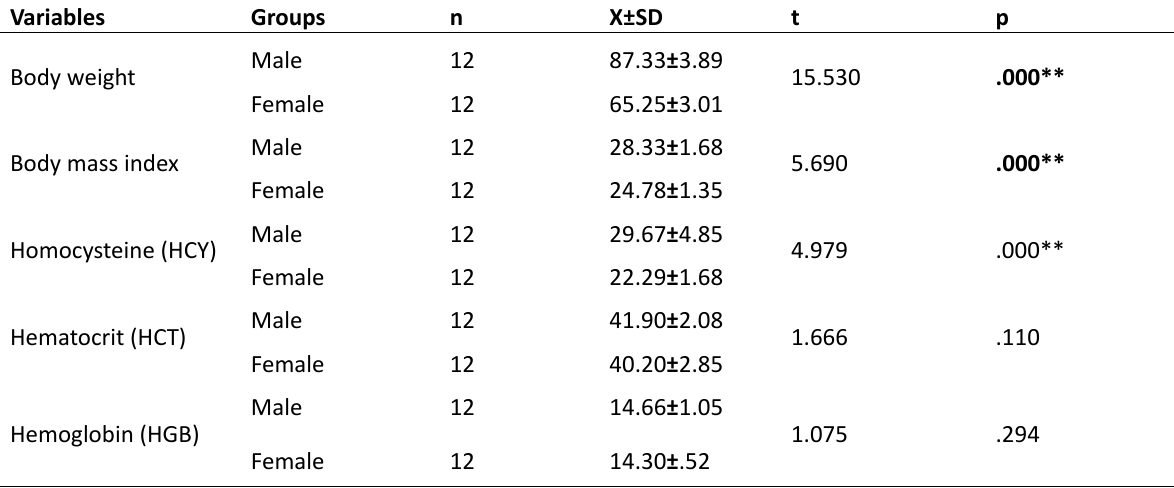
Table 3. Comparison of inter-group posttest values Variables